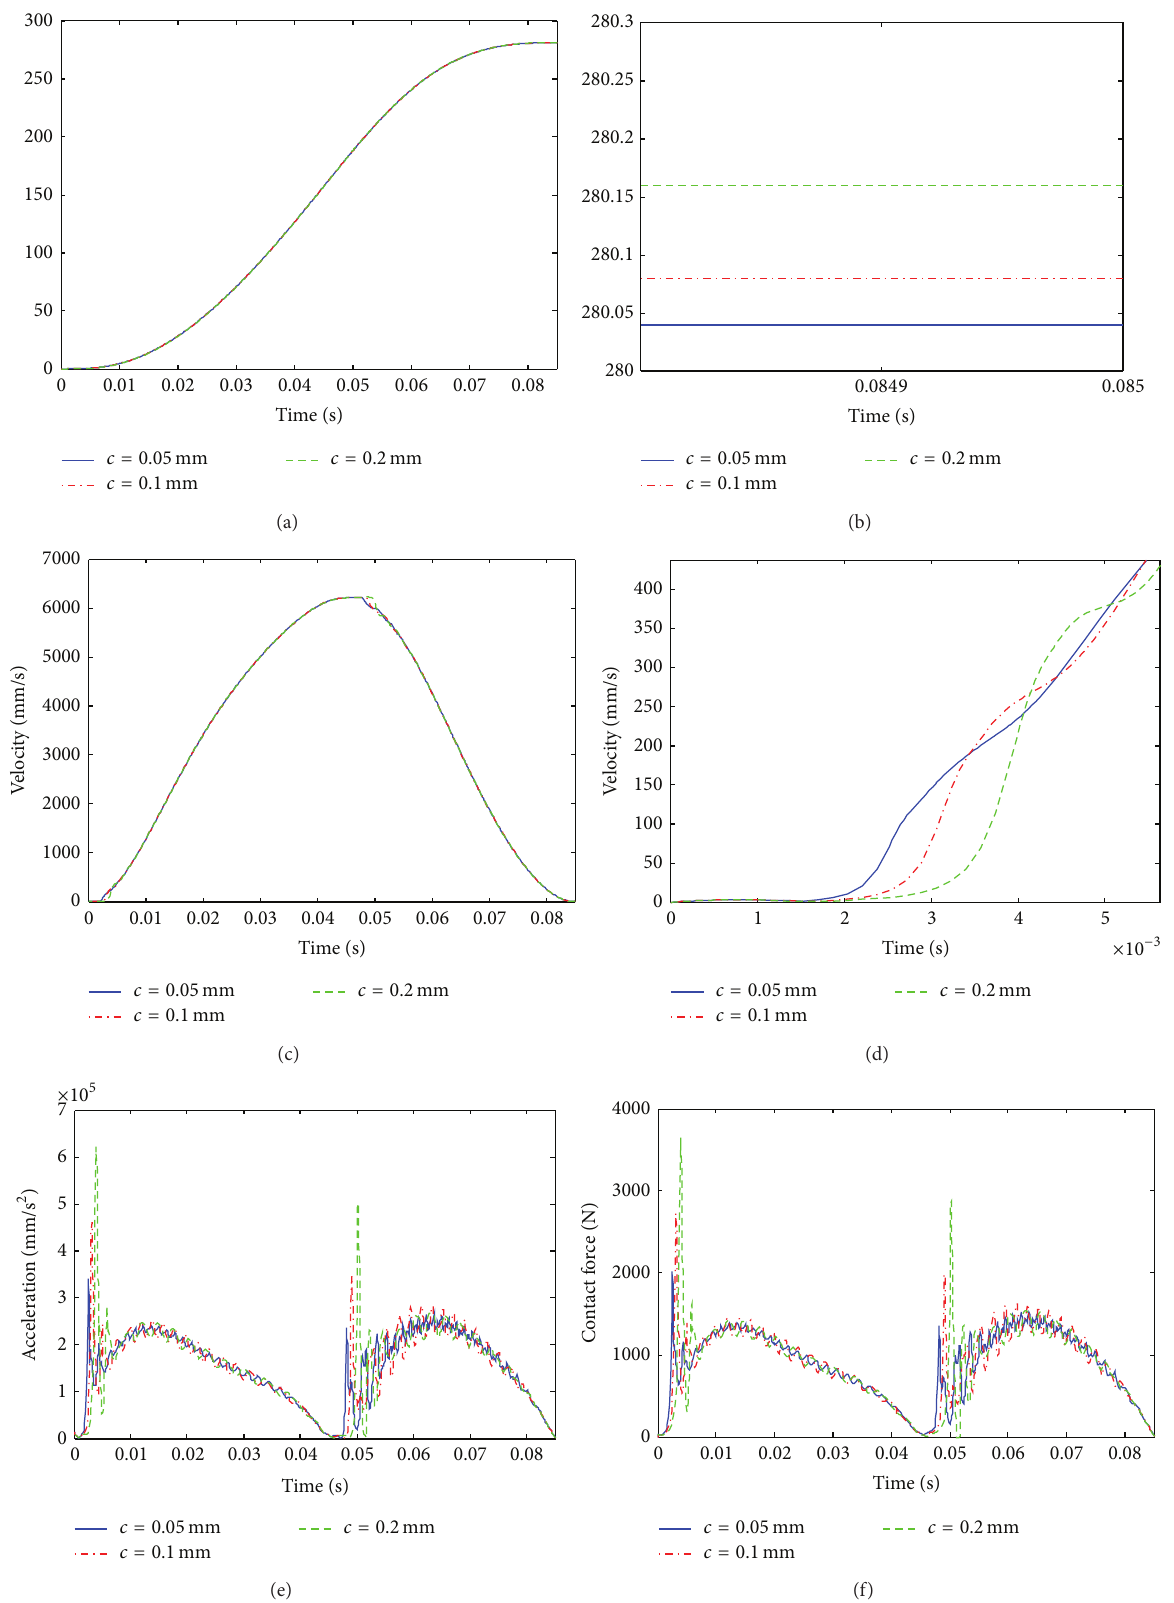
Figure 15: Responses for different clearance sizes: (a) displacement, (b) enlarged drawing of displacement, (c) velocity, (d) enlarged drawing of velocity, (e) acceleration, and (f) contact